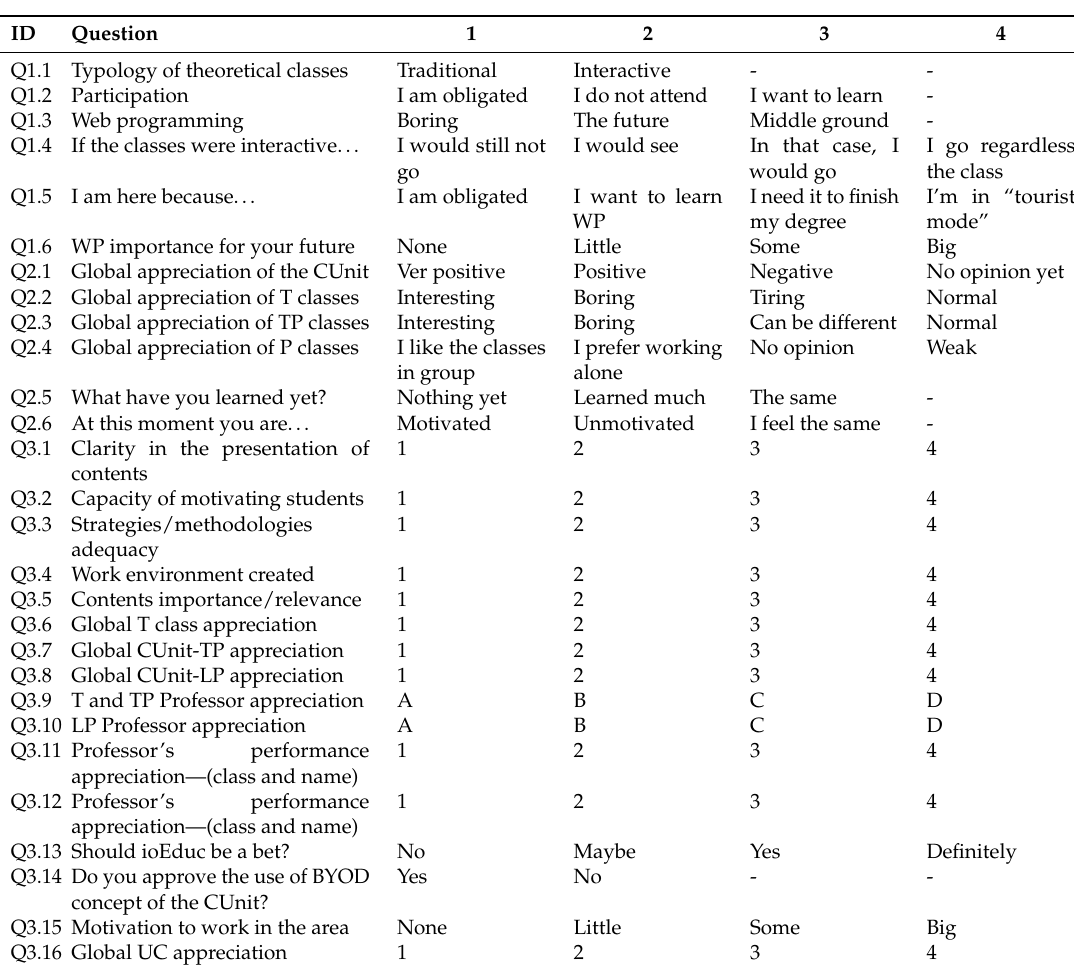
Table 5. Assessment classes